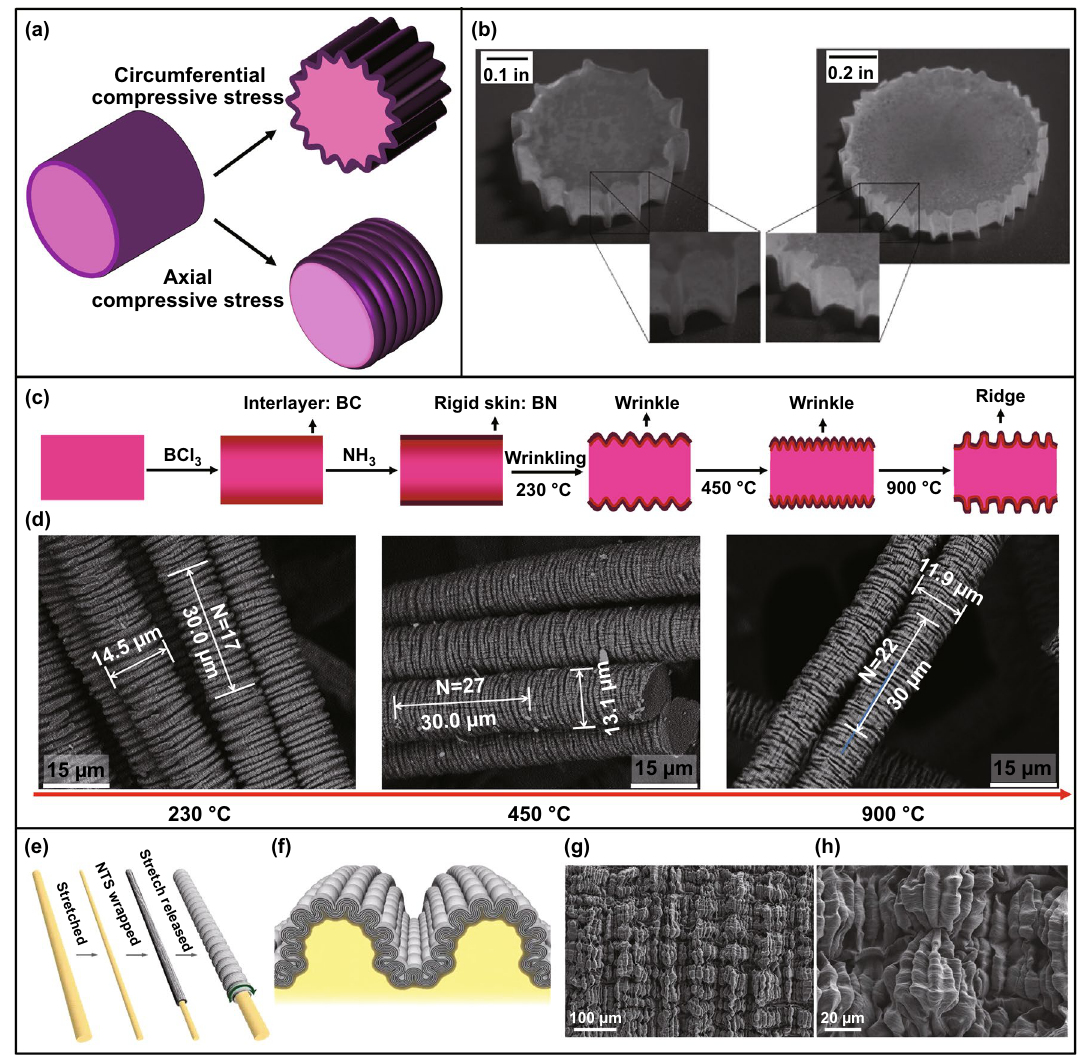
Fig. 7 Wrinkling patterns on solid core–shell cylinders under various deformation modes. a Schematic of compressive stress in axial and cir- cumferential directions of core–shell cylinders. b Images of the self-assembled gears [52]. Copyright 2009 Royal Society of Chemistry. c , d Schematic of the fabrication process starting from the PAN precursor fibers and SEM images of the wrinkled BN shells [58]. Copyright 2019 Elsevier. e – h Fabrication process and surface morphology of hierarchically buckled shell–core fibers: e schematic diagram of the fabrication process, f cross-sectional illustration of hierarchically buckled shell–core fibers, g , h SEM images of hierarchical buckles at 100% applied